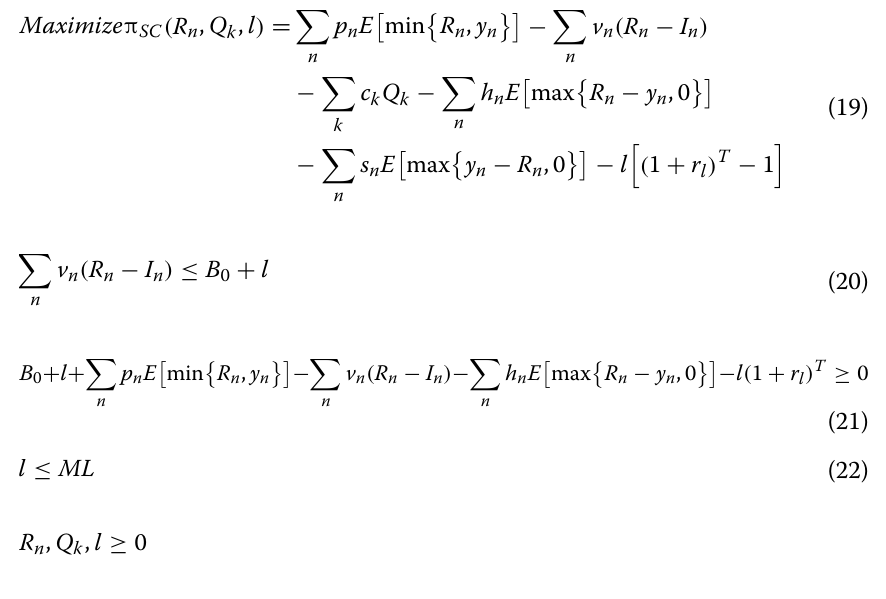
Fig. 2 Representation of the encoding of a strategy profile for all players, each x j k , where k D-dimension vector of supplier k’s decision